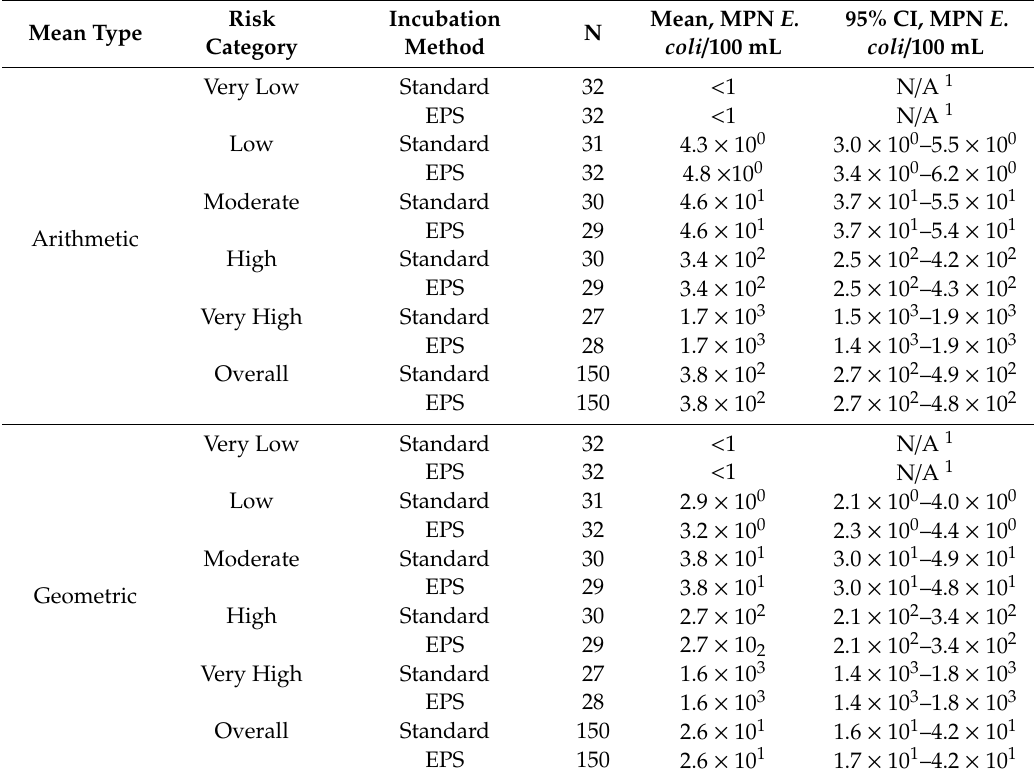
Figure 2. Correlation of E. coli counts between the EPS and standard incubation methods. Table 1. Arithmetic and geometric mean data from standard and EPS incubators.